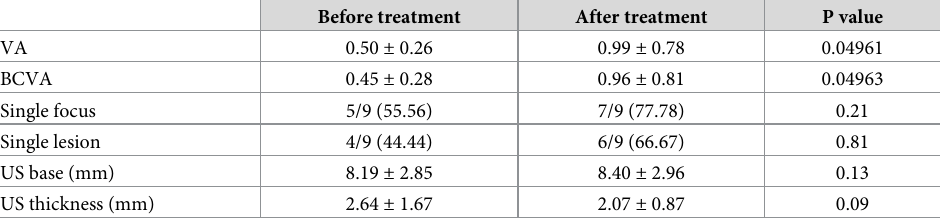
Table 6. Clinical characteristics of patients in the bevacizumab treatment group- prior and after